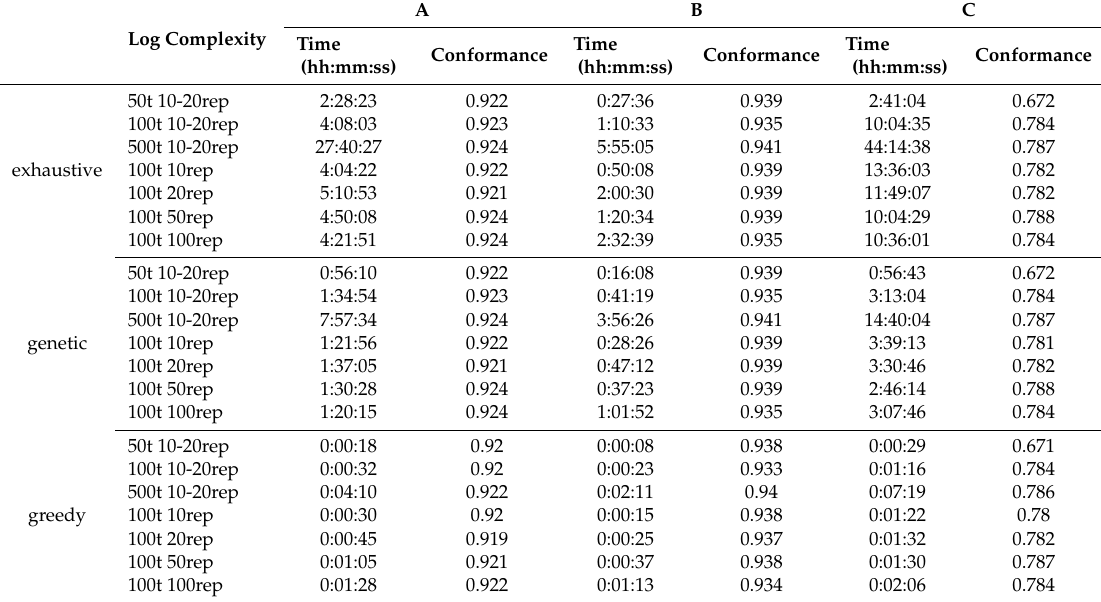
Table 8. Results obtained for all algorithms considering different log